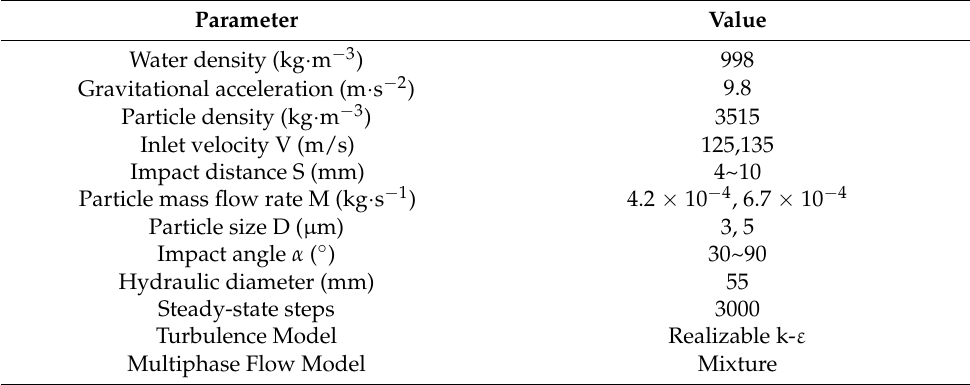
Table 2. The main parameters of the simulation.